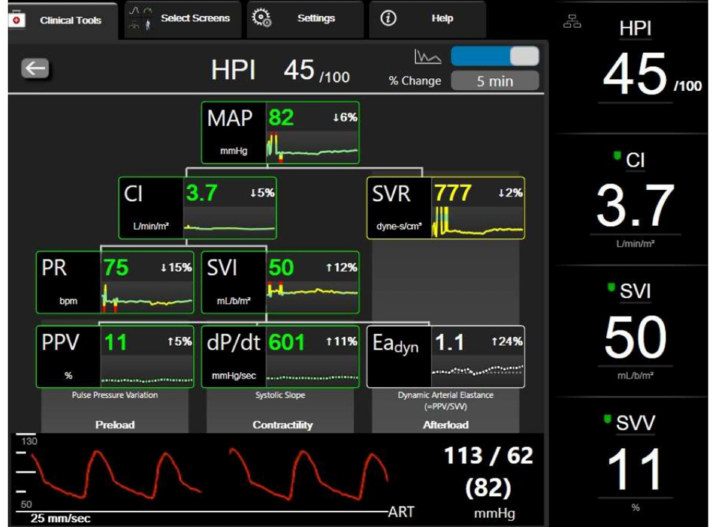
Figure 1. The secondary screen of the HPI algorithm (Edwards Lifesciences, Irvine, CA,